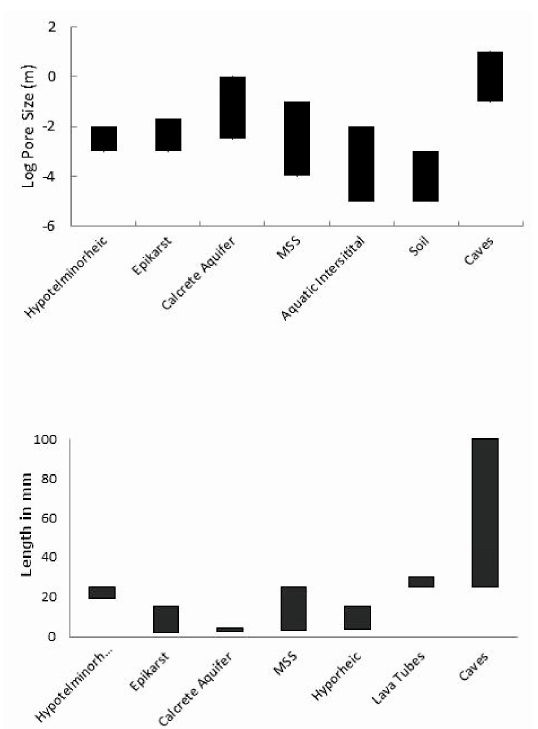
Figure 2. Histograms of body lengths of inhabitants (bottom) and log of pore size (top) for di ff erent subterranean habitats. From Pipan and Culver [24], modified. Log pore (habitat) size was used because the range of habitat sizes ranged over several magnitudes. The MSS (milieu souterrain superficiel) is the habitat of interconnected cracks and crevices of scree slopes, especially covered ones. Used with permission of the National Speleological Society ( www.caves.org ).